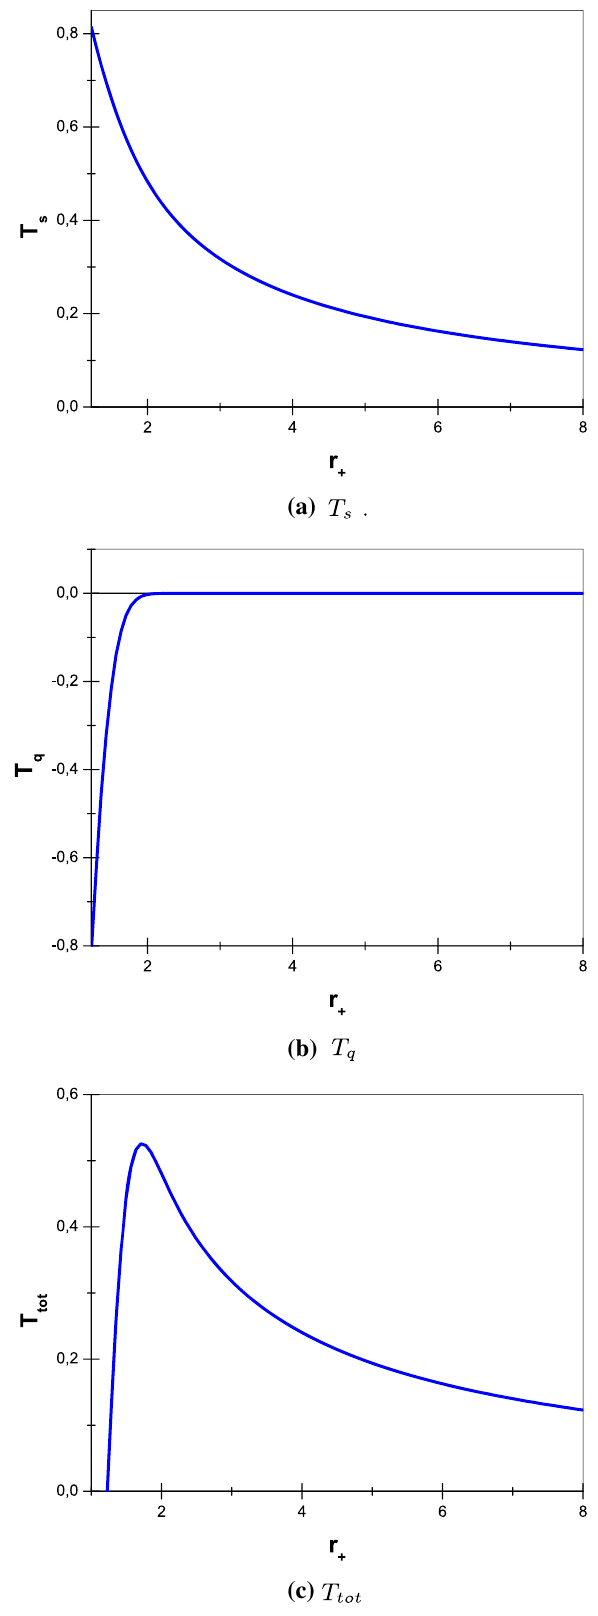
Fig. 2 Behavior of T s , T q and T tot for α = Q = R = 1, M q = 0 .